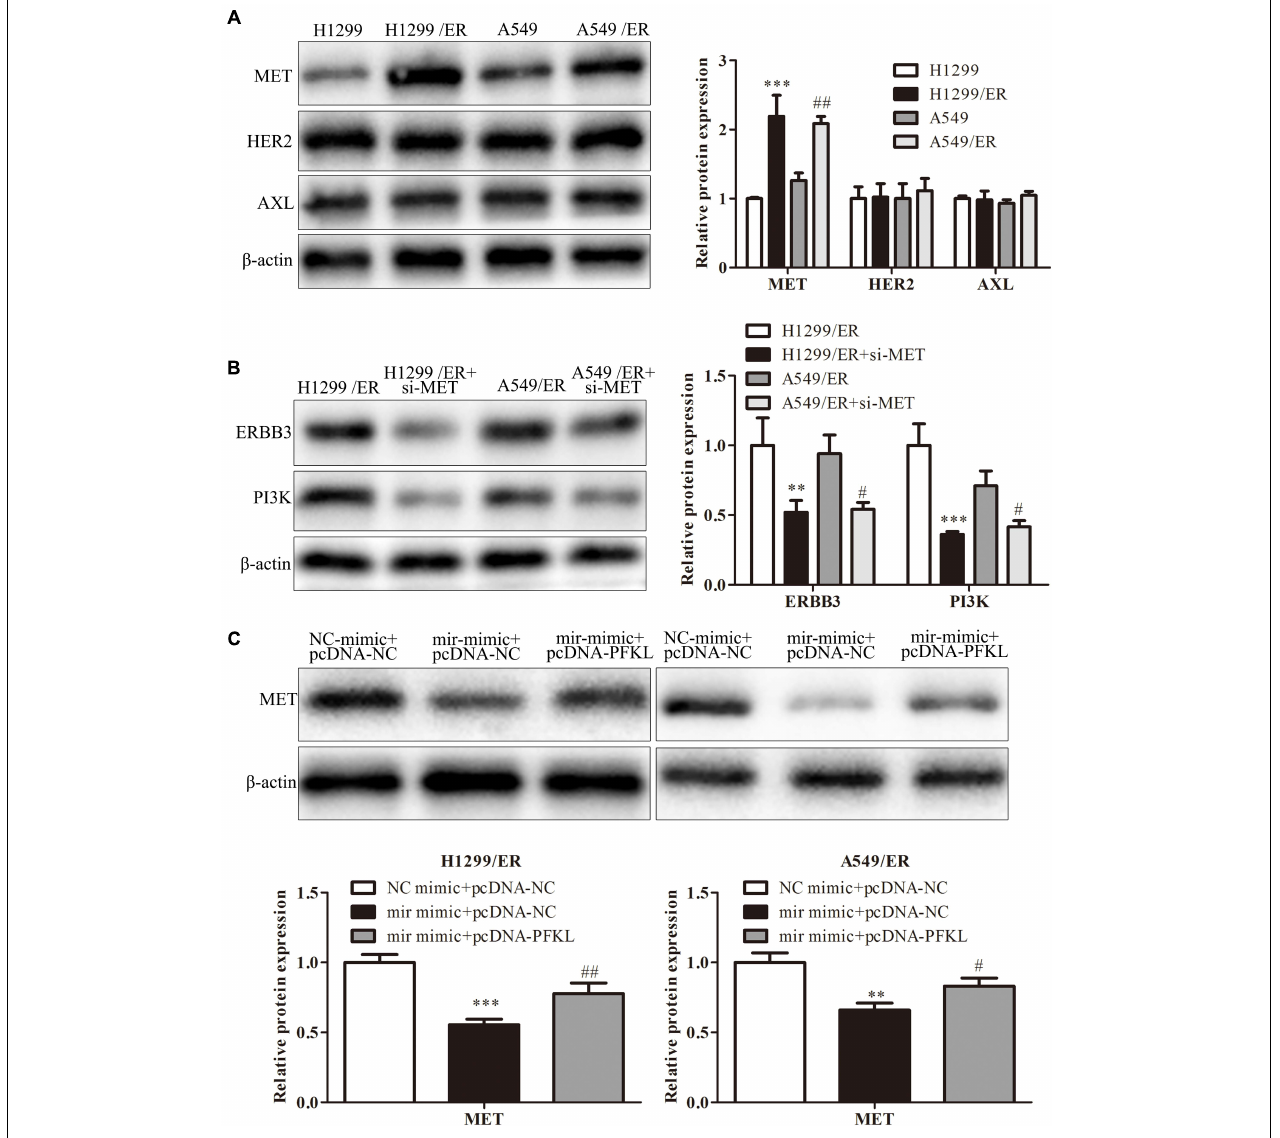
FIGURE 6 | MiR-185-3p/PFKL alleviates ER resistance of lung cancer by inhibiting the epidermal growth factor receptor (EGFR) alternative pathways. (A) The levels of MET, human epidermal growth factor receptor 2 (HER2), and AXL were determined by Western blot in H1299, A549, H1299/ER, and A549/ER cells. (B) The levels of Erb-B2 receptor tyrosine kinase 3 (ERBB3) and phosphoinositide 3-kinase (PI3K) were determined by Western blot in H1299, A549, H1299/ER, and A549/ER cells with or without si-MET. (C) The level of MET was determined by Western blot in H1299/ER and A549/ER cells. Data were shown as mean ± SD. ∗∗ p < 0.01; ∗∗∗ p < 0.001; # p < 0.05; ## p < 0.01.